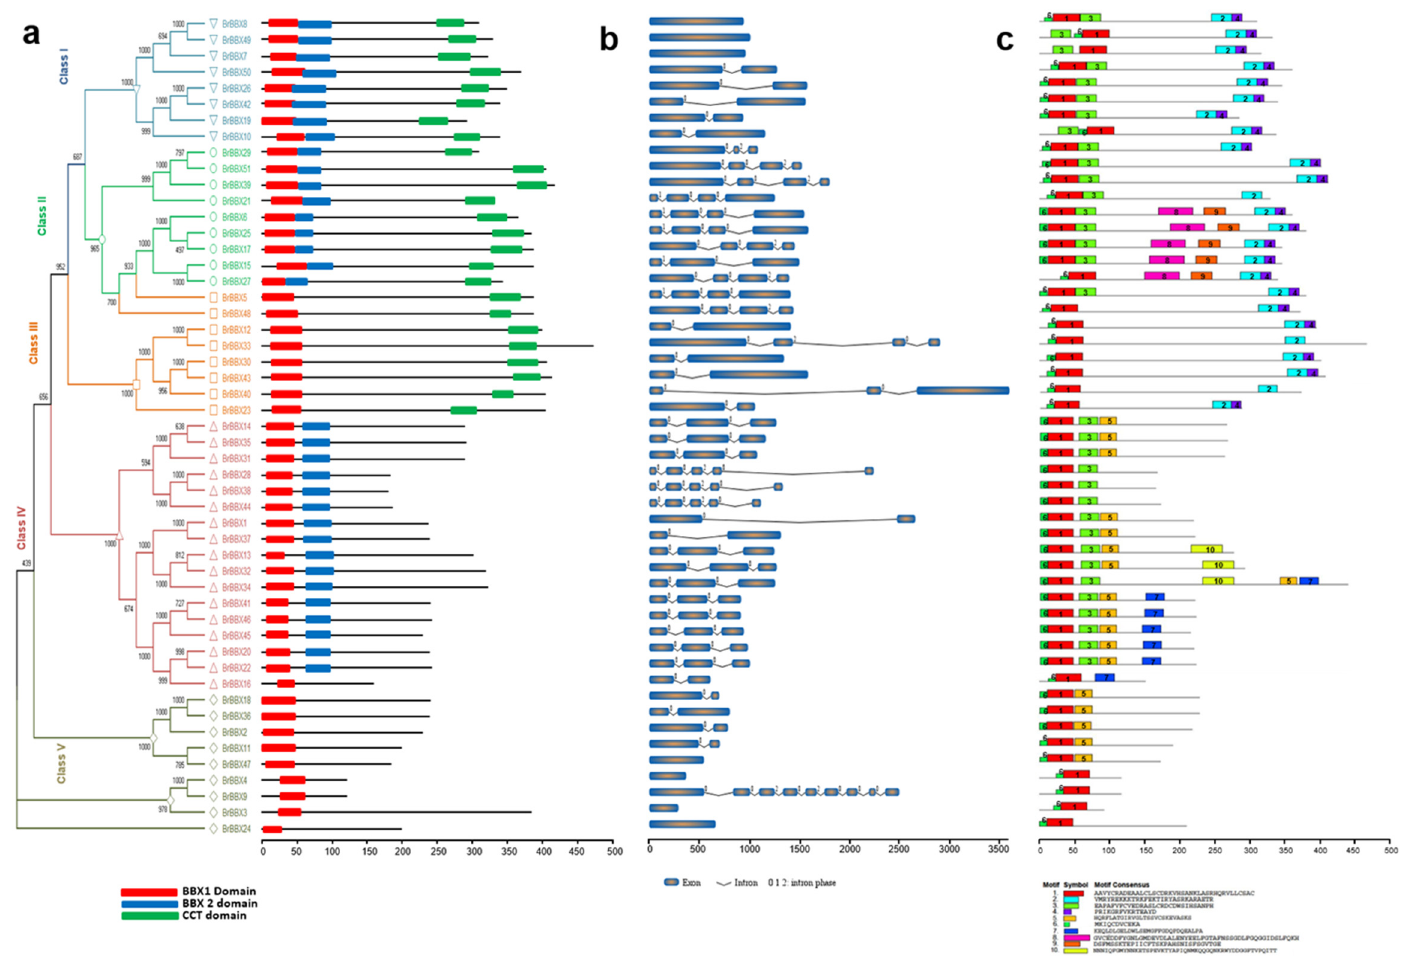
Figure 4. Brassica rapa B-box gene structures ( a ), motifs ( b ), and conserved domains ( c ). The domain architecture of the B-box genes is presented in panel a. Exons are represented by colored boxes, whereas introns are indicated by gray lines ( b ). Colored boxes indicate conserved motifs and gray lines represent non-conserved sequences. The motif lengths in each protein are presented proportionally. Classes I–V represent different groups of B-box family members in B. rapa.